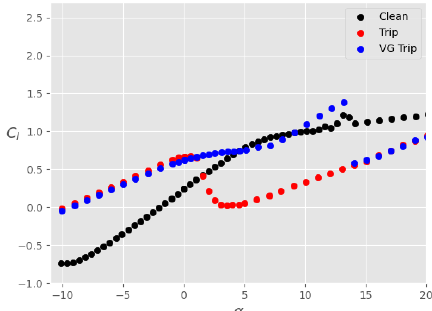
Figure 12. Lift coefficient C l as a function of the angle of at- tack α for a main element without slat: clean airfoil without VGs (black), tripped airfoil without VGs (red), and tripped airfoil with VGs